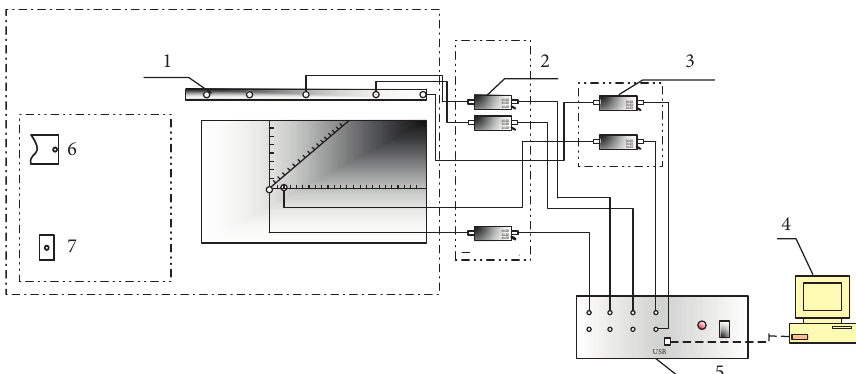
Figure 3: Experimental system. 1: RS-2A sensor; 2: adjustable gain amplifier; 3: adjustable gain amplifier of excitation pulse source; 4: computer; 5: acoustic emission analyzer; 6: top view of the position of the end face excitation pulse signal; 7: profile of the position of terminal excitation pulse